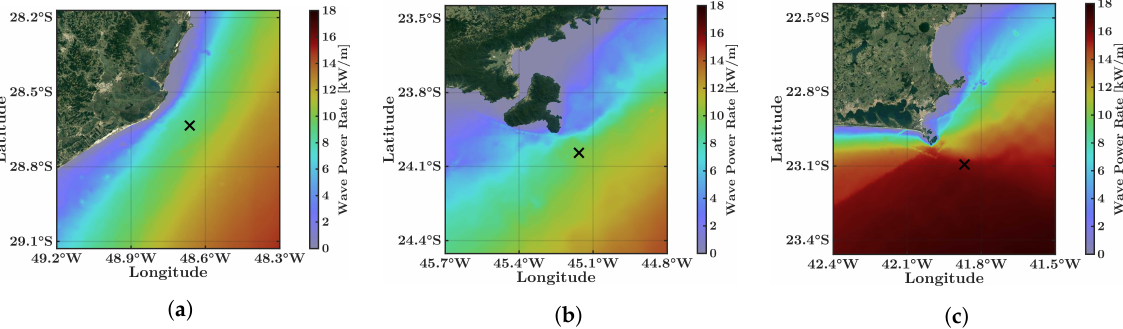
Figure 9. Mean value of wave power rate P w (kW/m) over the 18 years simulated. The “X” marks the position where the time series were extracted for the wavelet analysis in Section 3.3: ( a ) Laguna; ( b ) Ilhabela; and ( c ) Farol